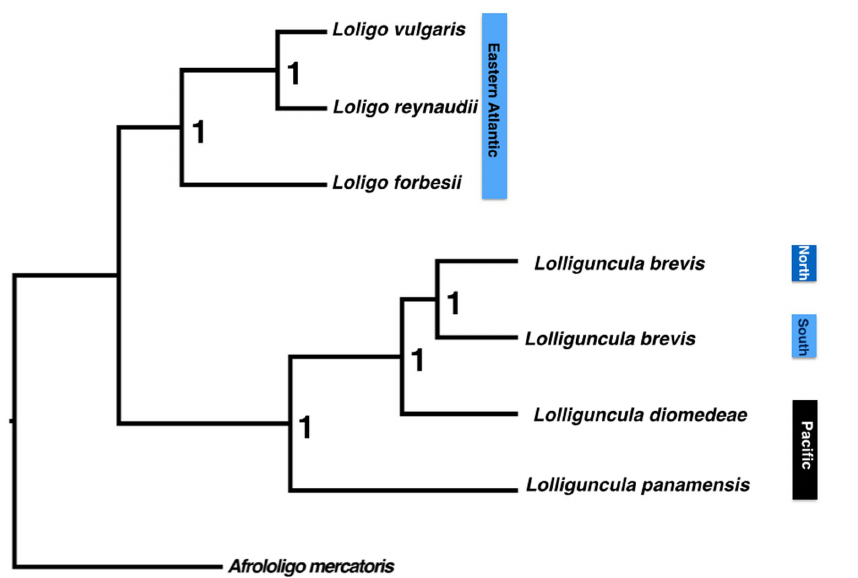
Figure 2. Partioned Bayesian Inference Phylogenetic tree of the genus Lolliguncula . Topology based on the concatened datasets (16S + COI + Rhod).